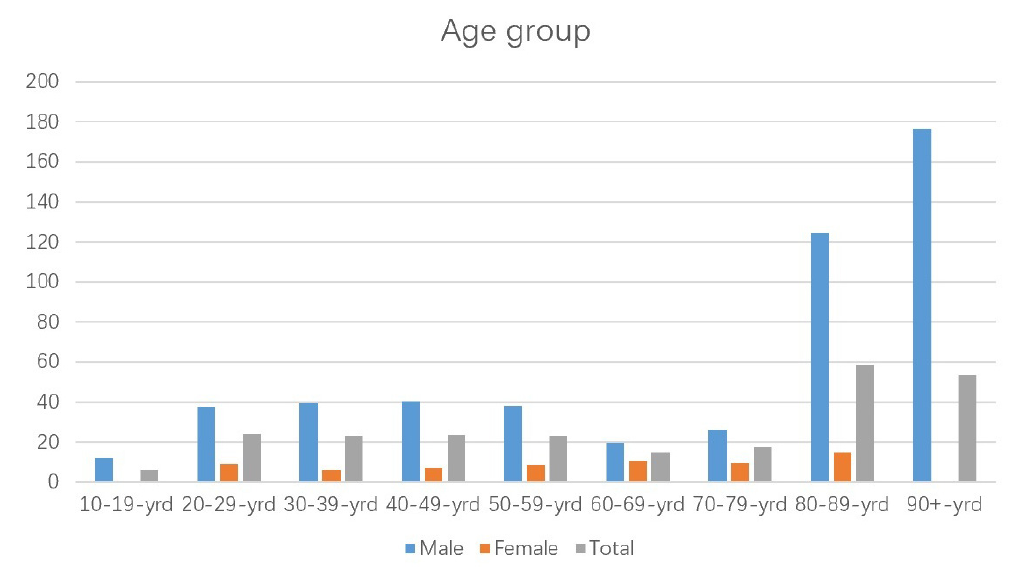
Fig. 4. The age group of the victims (cases per 100,000 population).